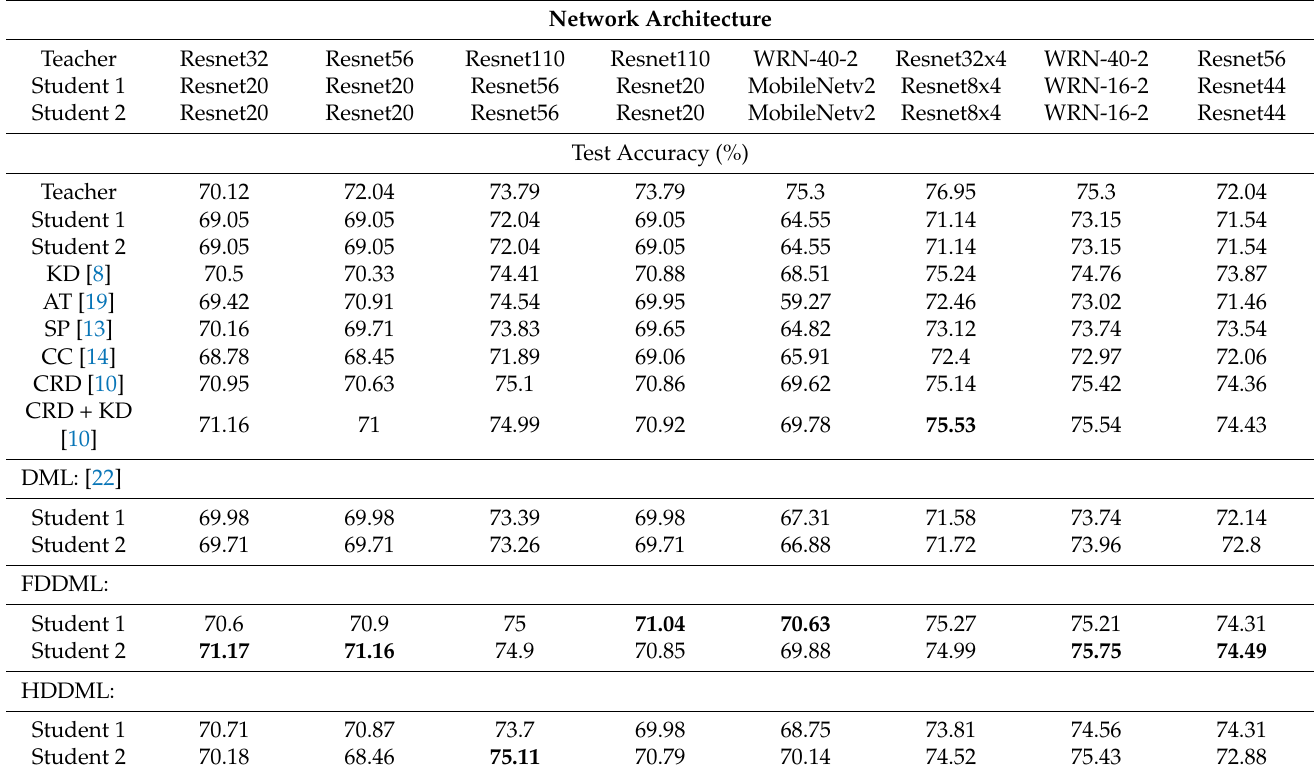
Table 2. Comparing resultstop-1 accuracy on the CIFAR-100 datasets with twin student network. Network